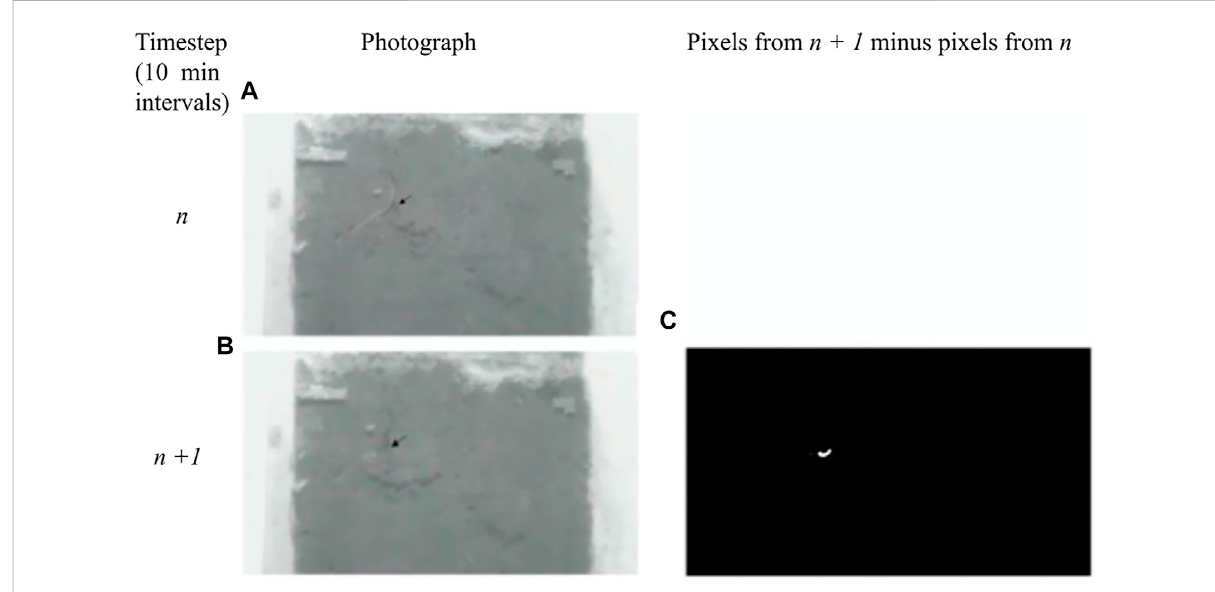
FIGURE 2 Examples of photographs and pixel images generated by this experiment. The cameras photographed enclosure faces once every 10 minutes, as shown in (A) and (B) . The earthworm seen in image A had changed its location 10 min later, as shown in image (B) . Our software translated the photographs into pixel images and subtracted the number of white pixels in newest image from the number of white pixels in the photo proceeding it, as shown in image (C) . The 24 white pixels in C cover an area of 15.7 mm 2 , showing that earthworms moved 1.57 mm 2 of soil per